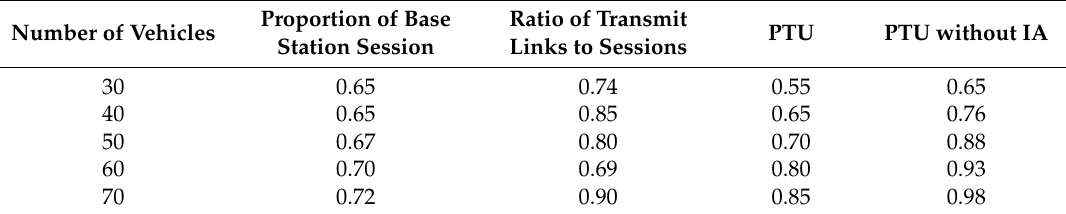
Table 8. PTU and Percentages of Sessions.